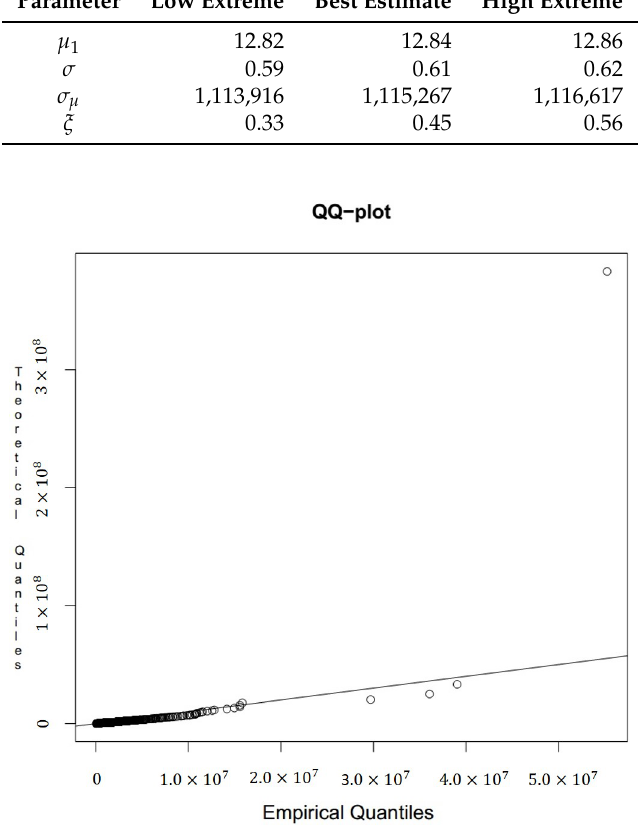
Figure 5. Observed–theoretical quantile plot for the Lognormal–GPD